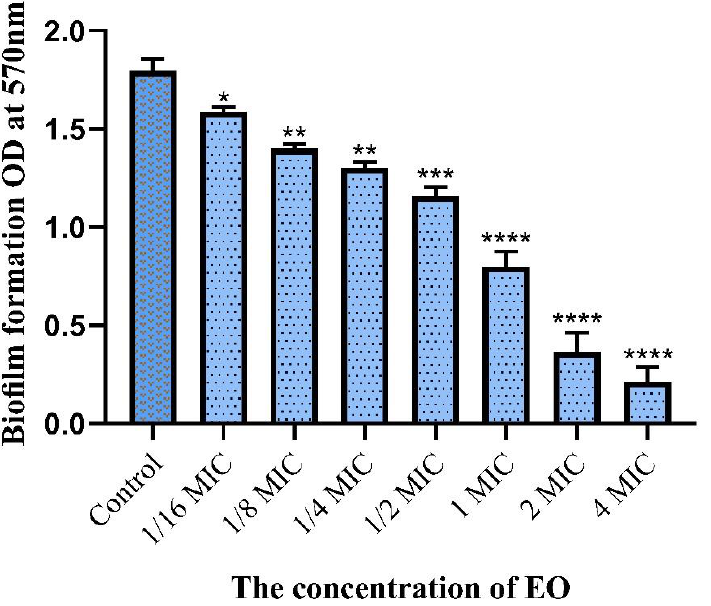
Figure 1. The effect of different concentrations of essential oil from M. nepalensis against biofilm formation of Staphylococcus aureus. Differences were statistically significant in relation to the control for * p < 0.05; ** p < 0.01; *** p < 0.001; **** p < 0.0001.